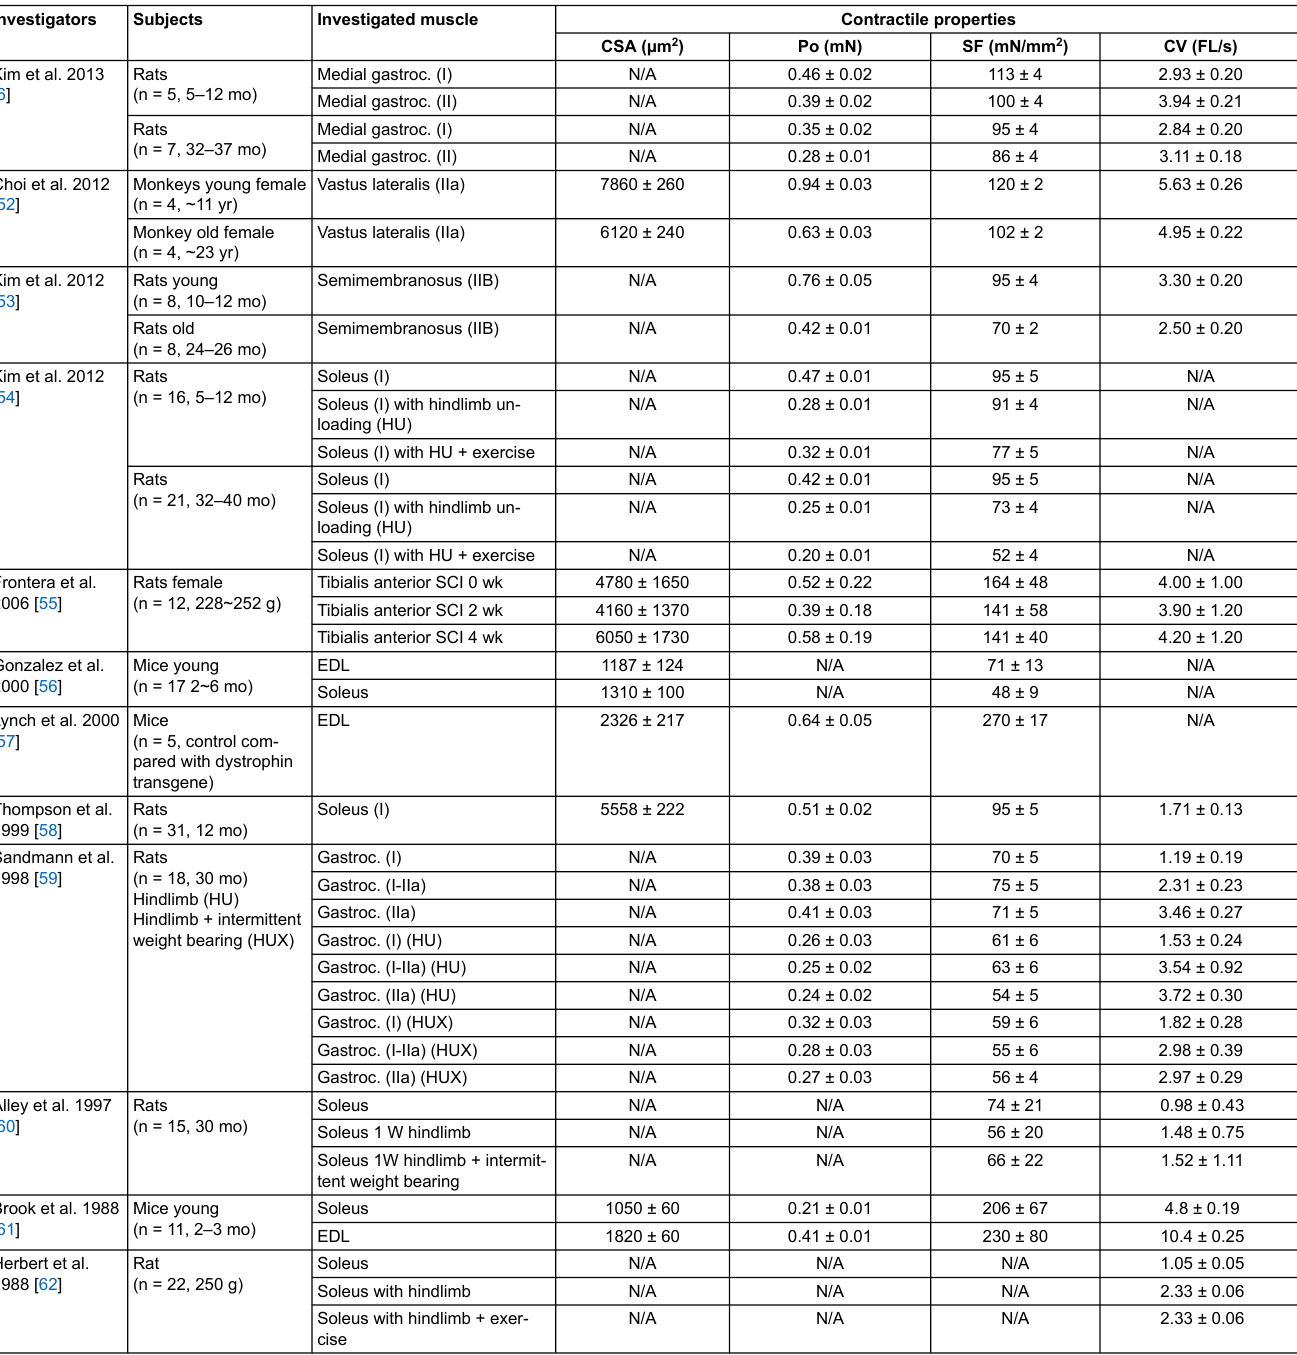
Table 4: Summary of single muscle fibre studies of